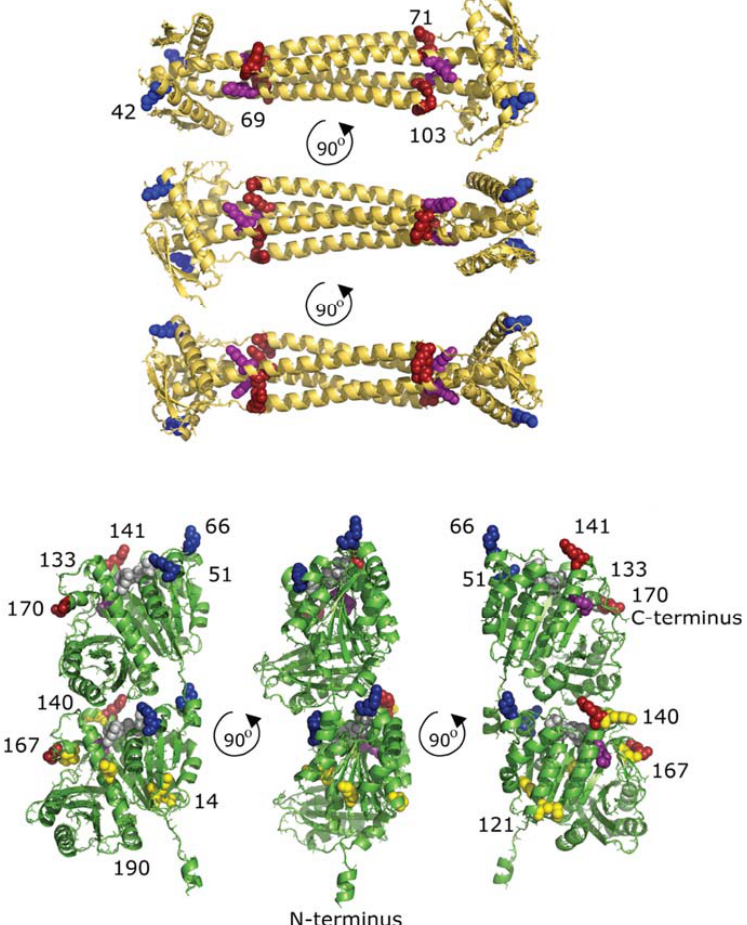
Figure 2. The ZapA structure (4P1M, [18]) in yellow and a model of the Escherichia coli FtsZ structure [38] in green with lysines involved in cross-links indicated. The K42 of ZapA cross-links with K51 and K66 of FtsZ (all blue). K71 and K103 (red) cross-link with each other and K71 cross-links with K69 (purple). In the upper molecule of the FtsZ dimer, the lysines that were found to cross-link are indicated. The C-terminal K380, which is not resolved in the model of the crystal structure, cross-links with K133 and K170 (both in red) and with K51 and K66. K141 in FtsZ also cross-links with K133 (purple). In the lower FtsZ molecule, the lysines that did not provide cross-links are indicated in yellow. The GTP connecting the two FtsZ monomers is shown in grey.